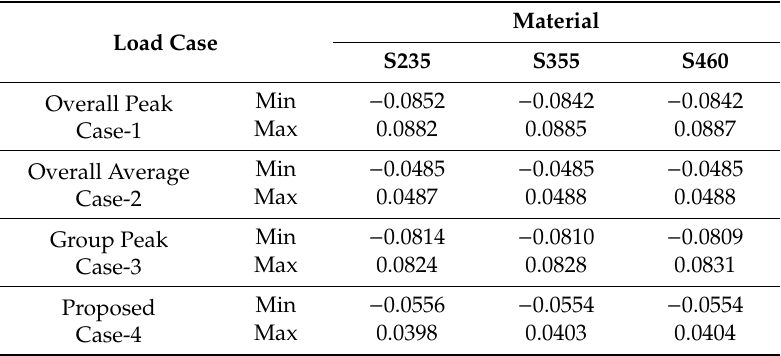
Table 8. Minimum and maximum displacements of frame (m).